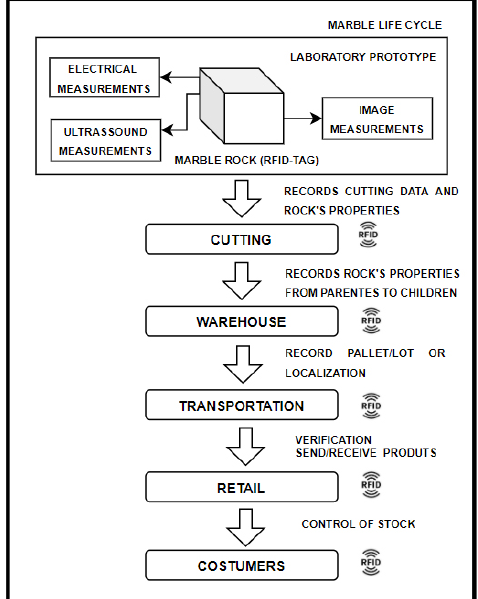
Figure 1. Marble Life Cycle.